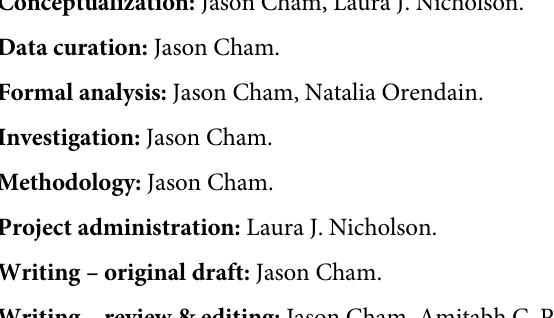
S1 Table. Raw Maverick SARS-CoV-2 multiantigen panel results. Raw values for IgM and IgG antibody response to respective SARS-CoV-2 epitopes at baseline, week 2, week 4, month 3 and month 6 in subjects administered Pfizer-BioNTech COVID-19 vaccine at week 0 and week 3. Antibody response is reported in Genalyte response units